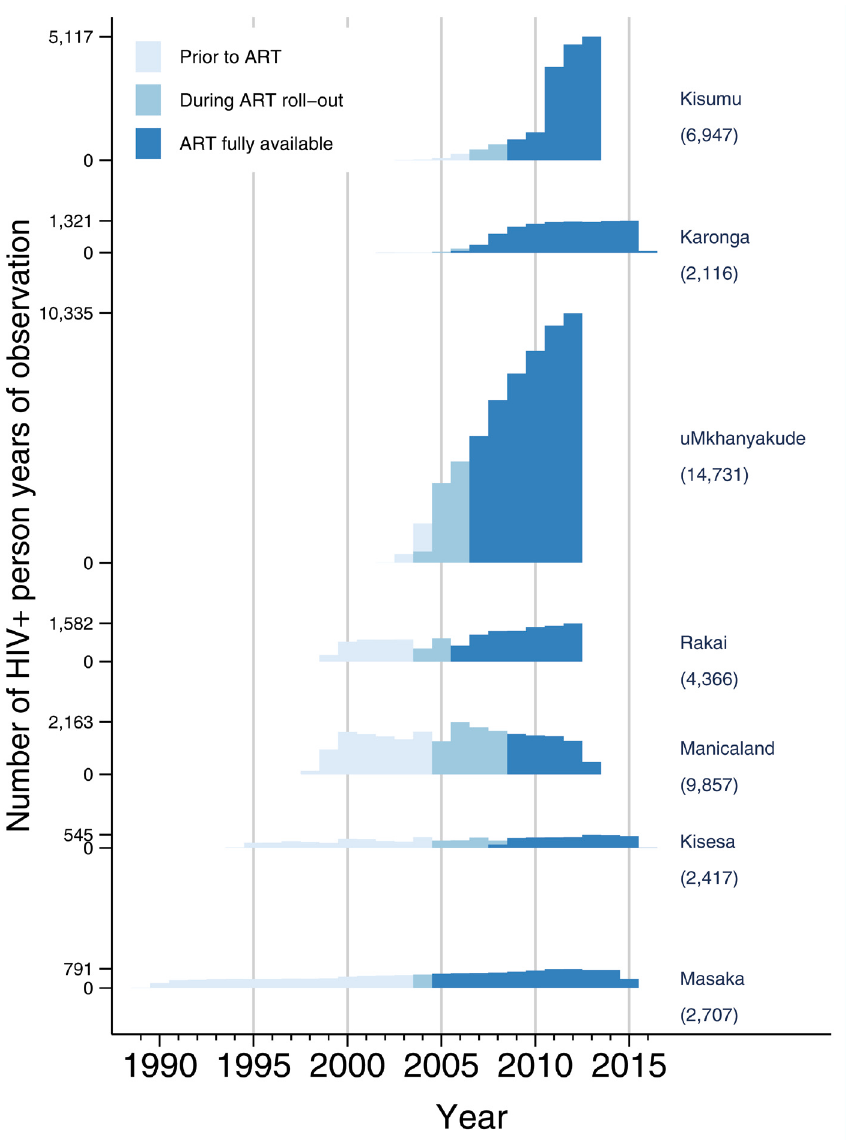
Figure 1. HIV positive person time by site and calendar year. Numbers in brackets give total number of PLHIV ever